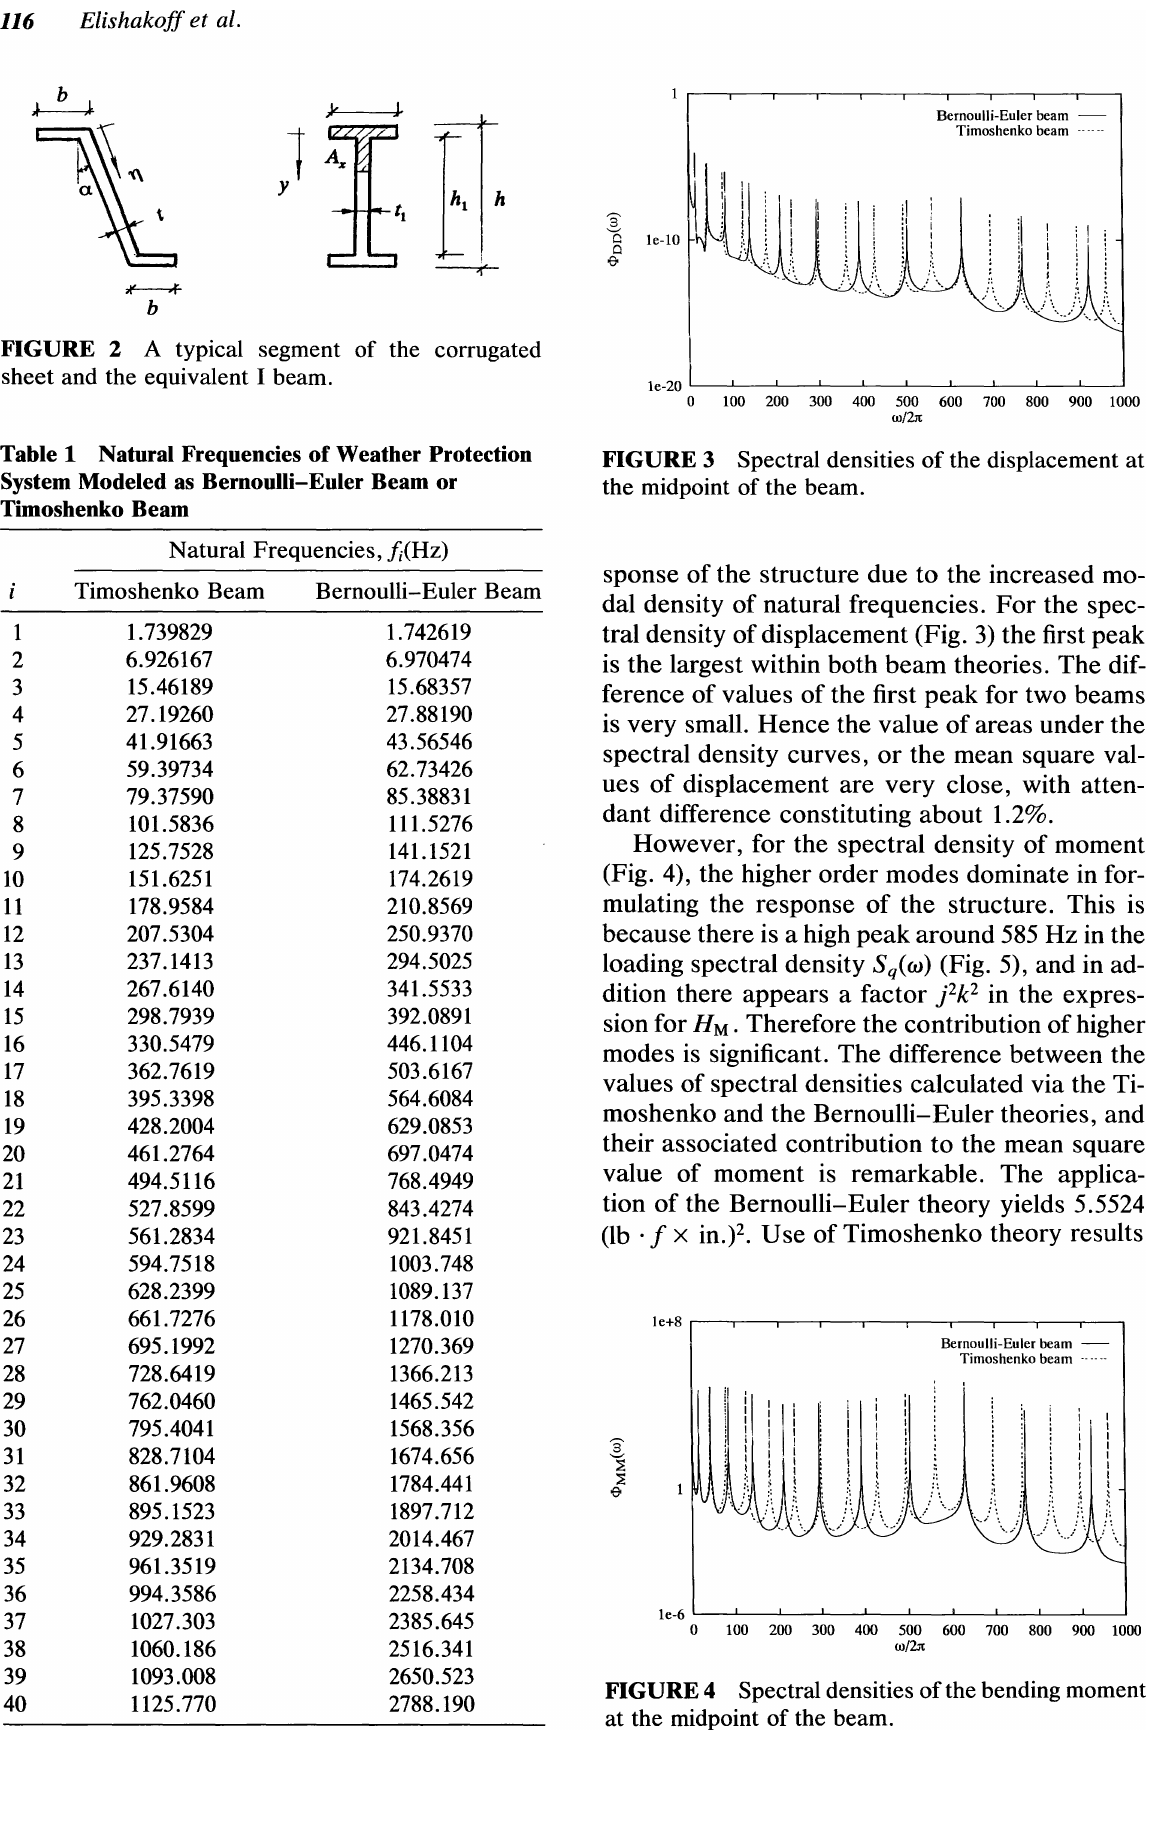
FIGURE 4 Spectral densities ofthe bending moment at the midpoint of the